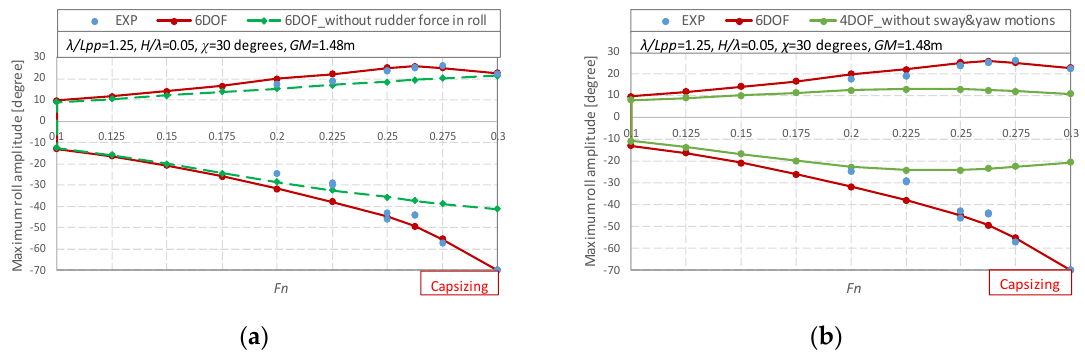
direction with φ = 20, −2 0 degree, ( a ) starboard; ( b ) port. direction with ϕ = 20, − 20 degree, ( a ) starboard; ( b ) port.